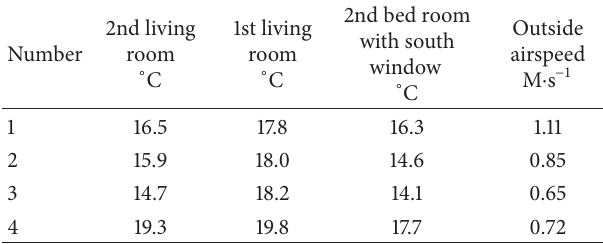
Table 11: Indoor air temperature test results during heating condi- tions.